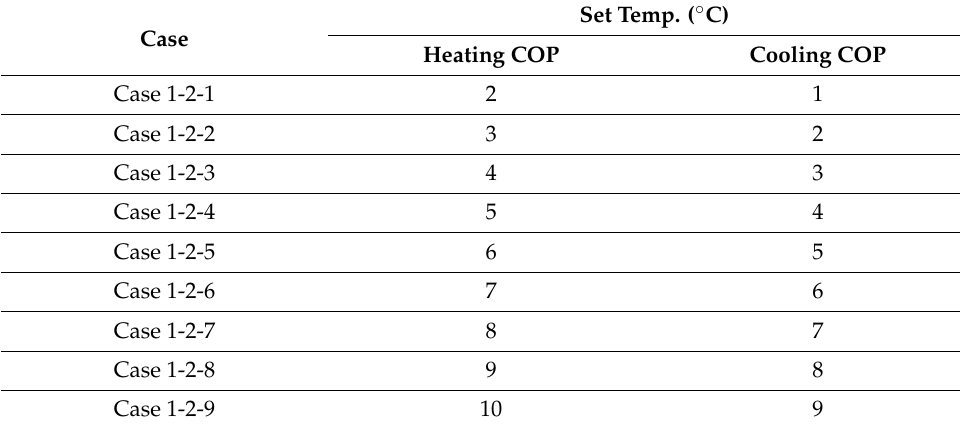
Table 2. Subcases of Case 1-2 for various heating and cooling